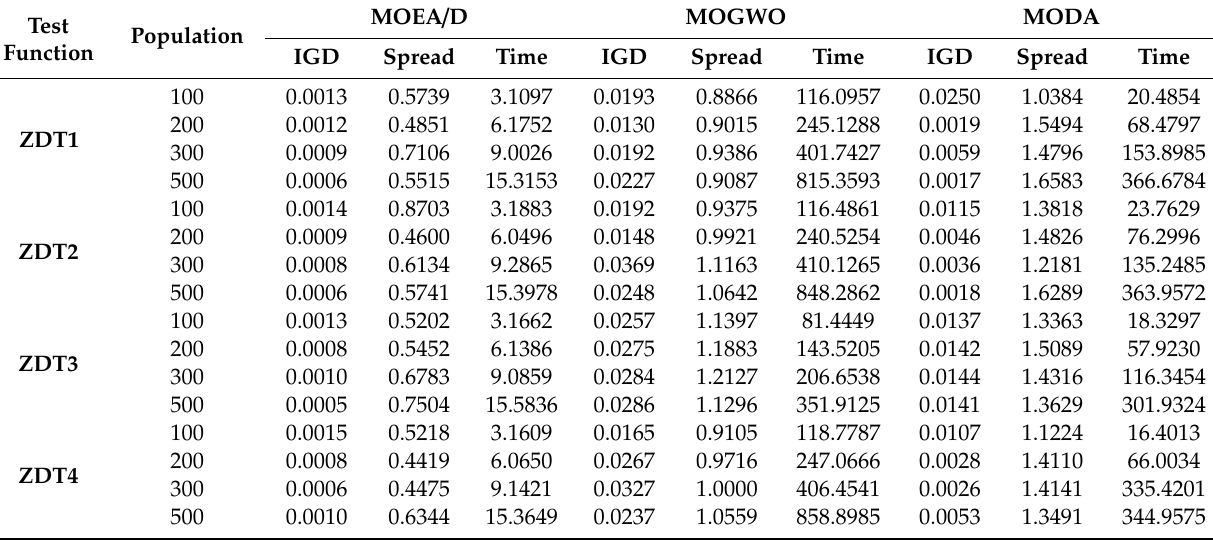
Table 12. Results of MOEA / D and compared algorithms Multi-objective Grey Wolf Optimization (MOGWO), Multi-objective Ant Lion Optimizer (MOALO) and Multi-objective Dragonfly Algorithm